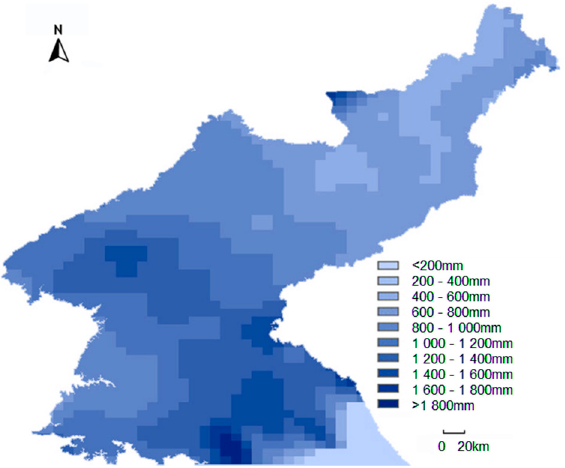
Figure 4. Spatial distribution of average annual precipitation evaluated over the 1961–2010 period (cell size: 10.0 km × 7.1 km).